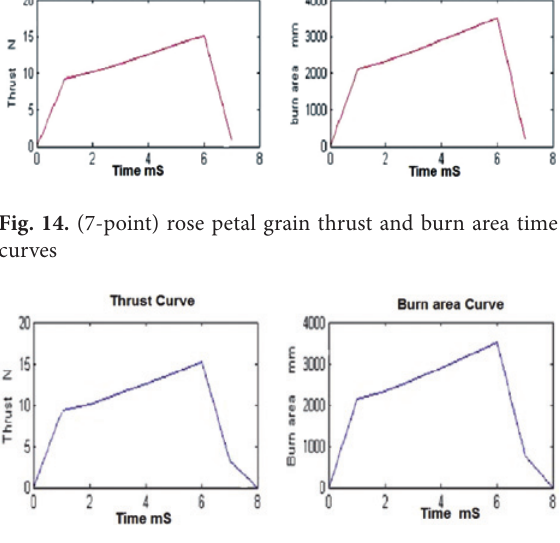
Fig. 15. (6-point) star grain thrust and burn area time curves From 0 to 1 msec, both curves increase linearly at the commencement of the start of burning.